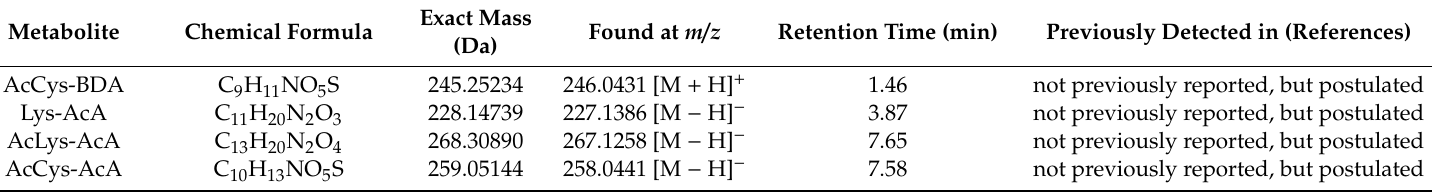
Table 2. Exact mass, found mass, and retention time of each furan and 2-methylfuran metabolite identified by UPLC-qToF-MS / MS, and matrices in which they have been previously found (with supporting references). Meanings of the abbreviated metabolites’ names are given in the text or present the meanings in a